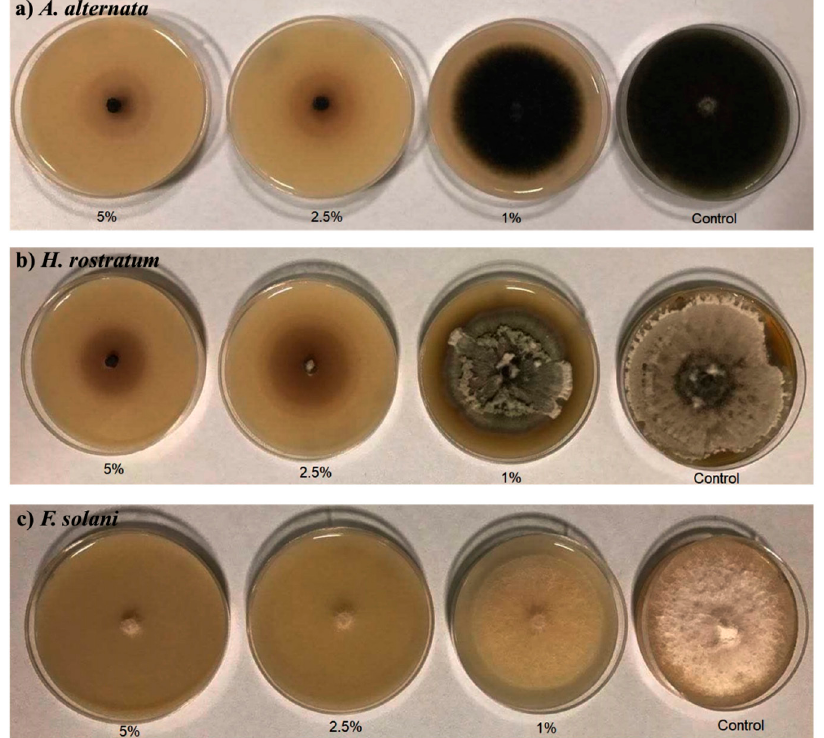
Fig. 1. In vitro activity of aqueous extract of Boswellia carteri on three phytopathogenic fungi; 1a) A. alternata, 1b) H. rostratum and 1c) F.